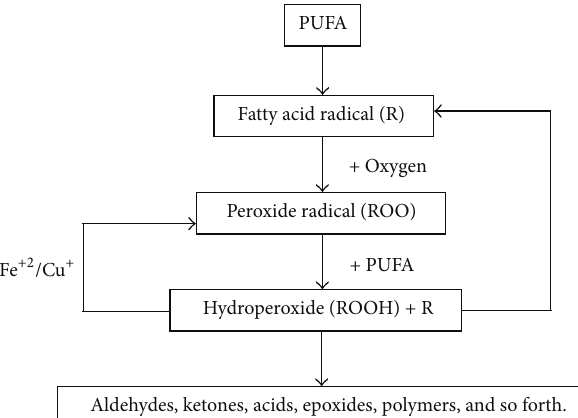
Figure 2: Lipid oxidation is an autocatalytic process that occurs in food and biological membranes [23]. Aldehydes produced are the major contributors to off-flavors of beef